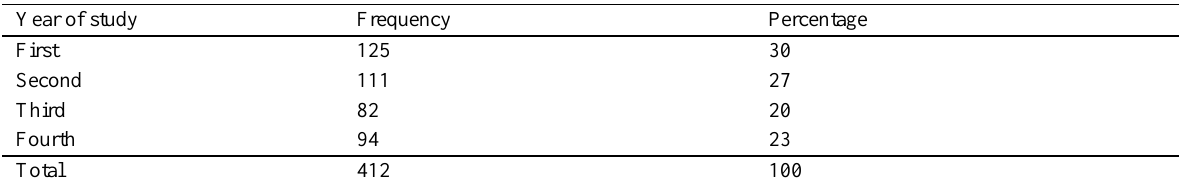
Table 2: Year of study of